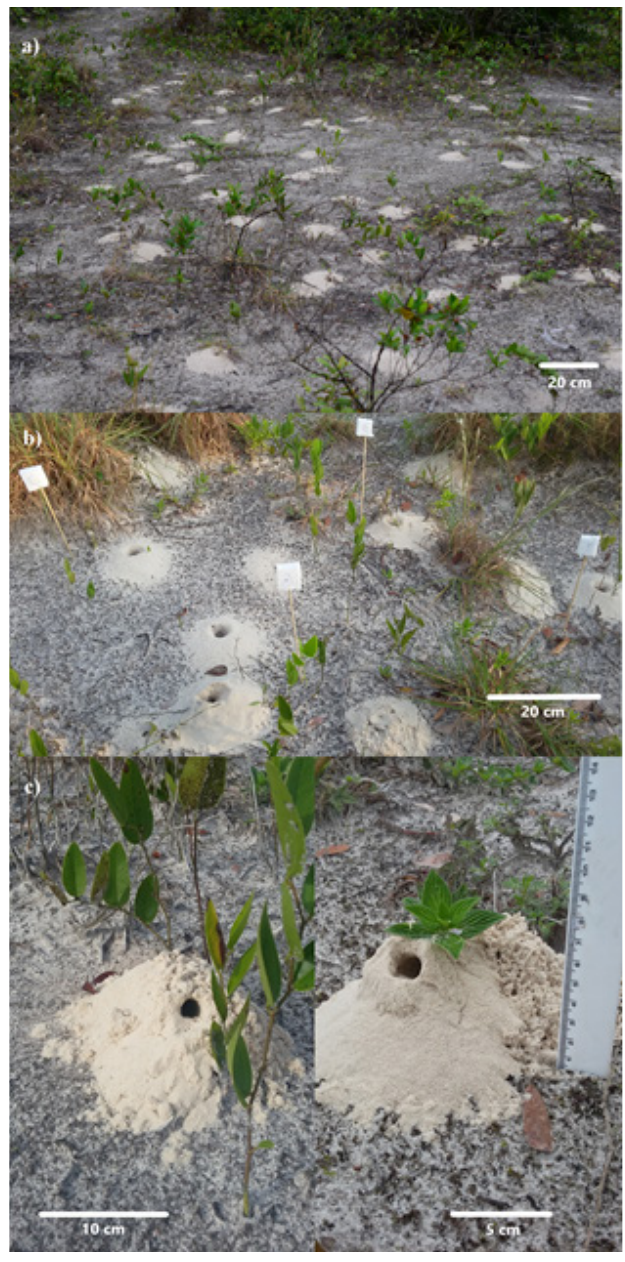
Fig 1 . (a) General view of Epicharis dejeanii nest aggregation in the study area. (b) A view of several tumuli around the nest entrances and styrofoam plates positioned next to the nest entrances for identification. (c) Detail of the